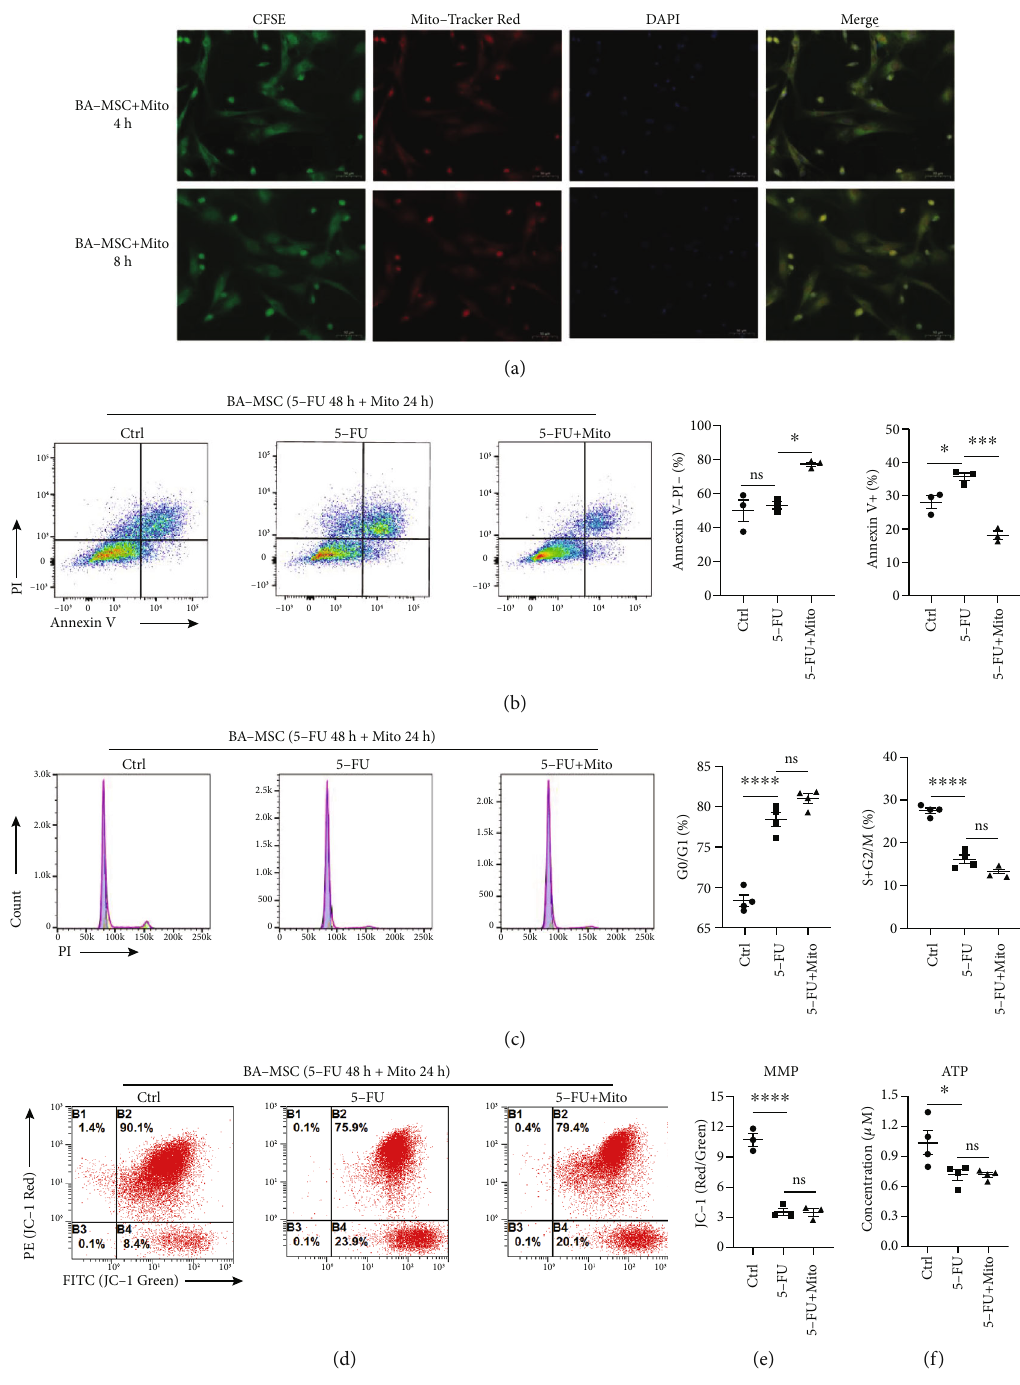
Figure 5: Evaluation of the e ffi cacy of platelet-derived mitochondria in the treatment of BA-MSCs injured by 5-FU. (a) Representative fl uorescence images of BA-MSCs after 4h and 8h incubation with platelet-derived mitochondria. Mitochondria were previously labeled with MitoTracker Red CMXRos (red signal). The cytoplasm of BA-MSCs was labeled with CFSE (green signal), and the nucleus was labeled with DAPI (blue signal) before detection. (b) After incubation of 5-FU-injured BA-MSCs with platelet-derived mitochondria for 24h, the apoptosis of BA-MSCs was analyzed by fl ow cytometry. (c) After incubation of 5-FU-injured BA-MSCs with platelet-derived mitochondria for 24h, the cell cycle of BA-MSCs was analyzed by fl ow cytometry. (d, e) After incubation of 5-FU-injured BA-MSCs with platelet-derived mitochondria for 24 h, the MMP of BA-MSCs was analyzed by fl ow cytometry. (f) After incubation of 5-FU- injured BA-MSCs with platelet-derived mitochondria for 24 h, the ATP of BA-MSCs was analyzed. Control group: BA-MSCs were treated with DMSO for 48h. 5-FU group: BA-MSCs were treated with 5-FU for 48 h. 5-FU +Mito group: BA-MSCs were treated with 5- FU for 48h and incubated with platelet-derived mitochondria for 24h. All data are presented as mean ± SEM . Statistics: one-way ANOVA (ns: not signi fi cant; ∗ p < 0 : 05 , ∗∗∗ p < 0 : 001 , and ∗∗∗∗ p < 0 : 0001